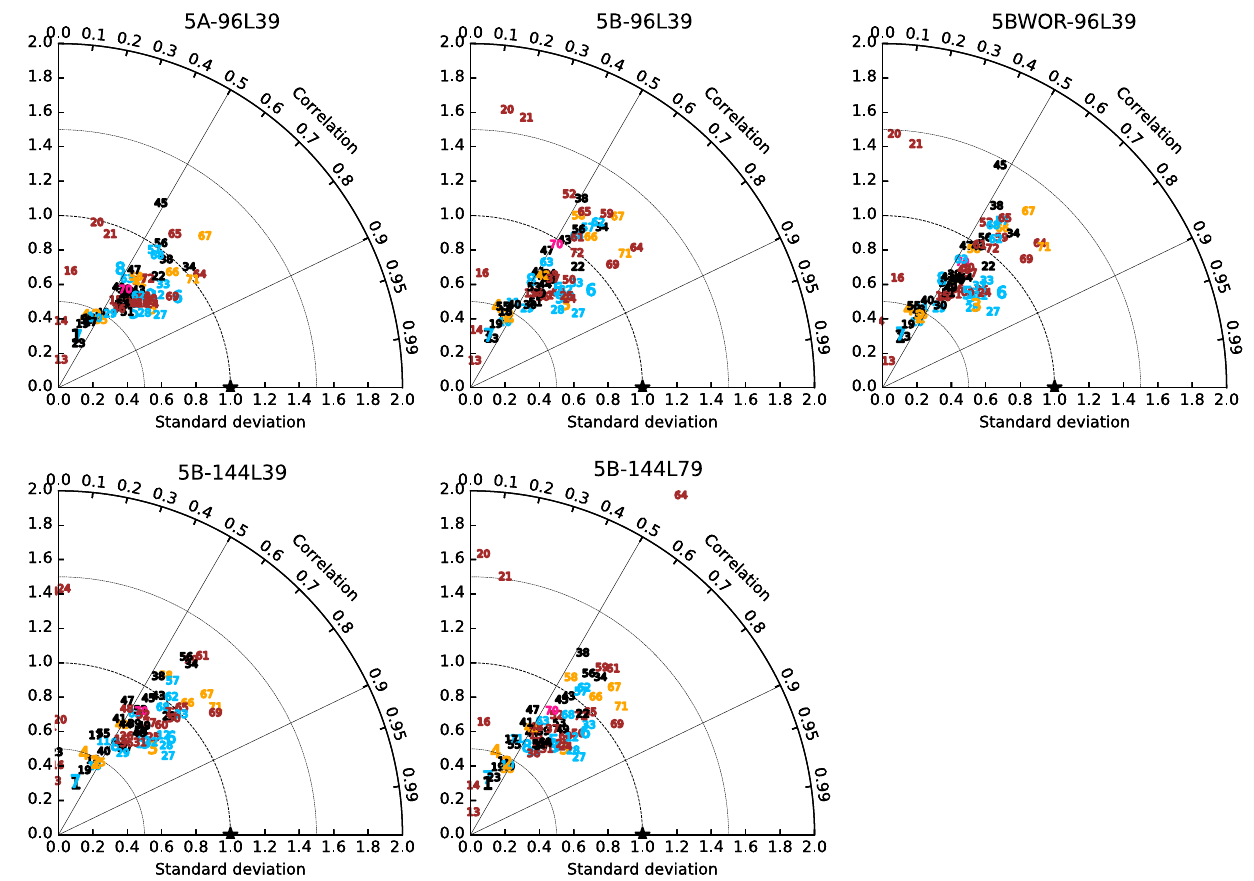
Figure 8. Taylor diagrams showing correlations and normalized standard deviations (NSDs: the ratio of the simulated to observed standard deviation) between the simulated and observed CO 2 synoptic variability for all surface stations. The stations are numbered and coloured as in Fig.